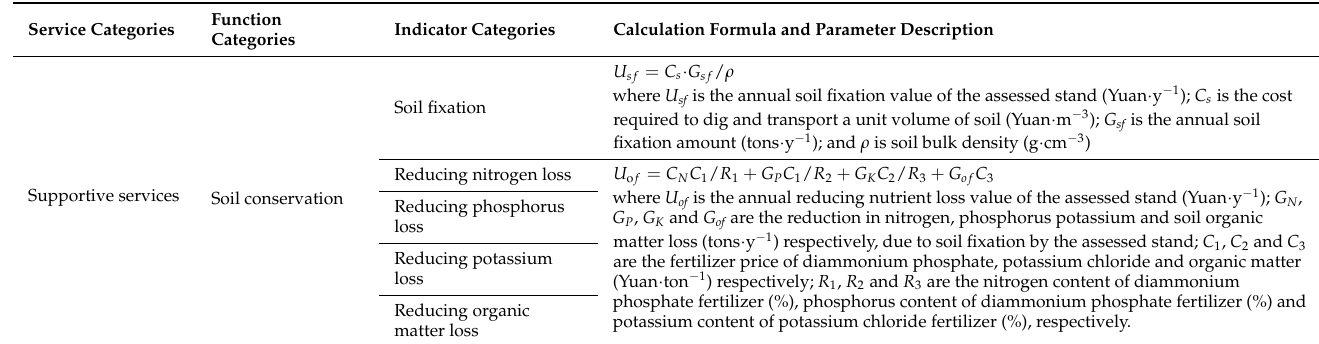
Table 1. Evaluation method for the ecological benefit value of the CFFG project.